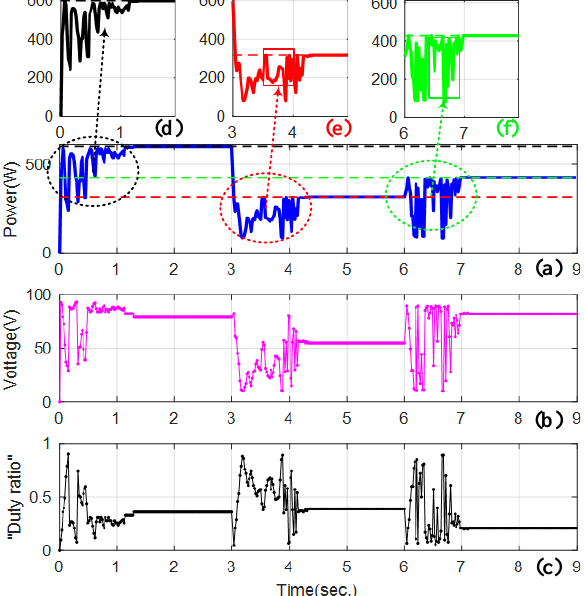
Figure 8. Results of the GWA method for three serial panels. ( a ) PV power, ( b ) PV voltage, ( c ) duty ratio, and ( d – f ) transient trajectories for situations 1–3, respectively. (Black –, red –, green –: global maximum values of situations 1 – 3).